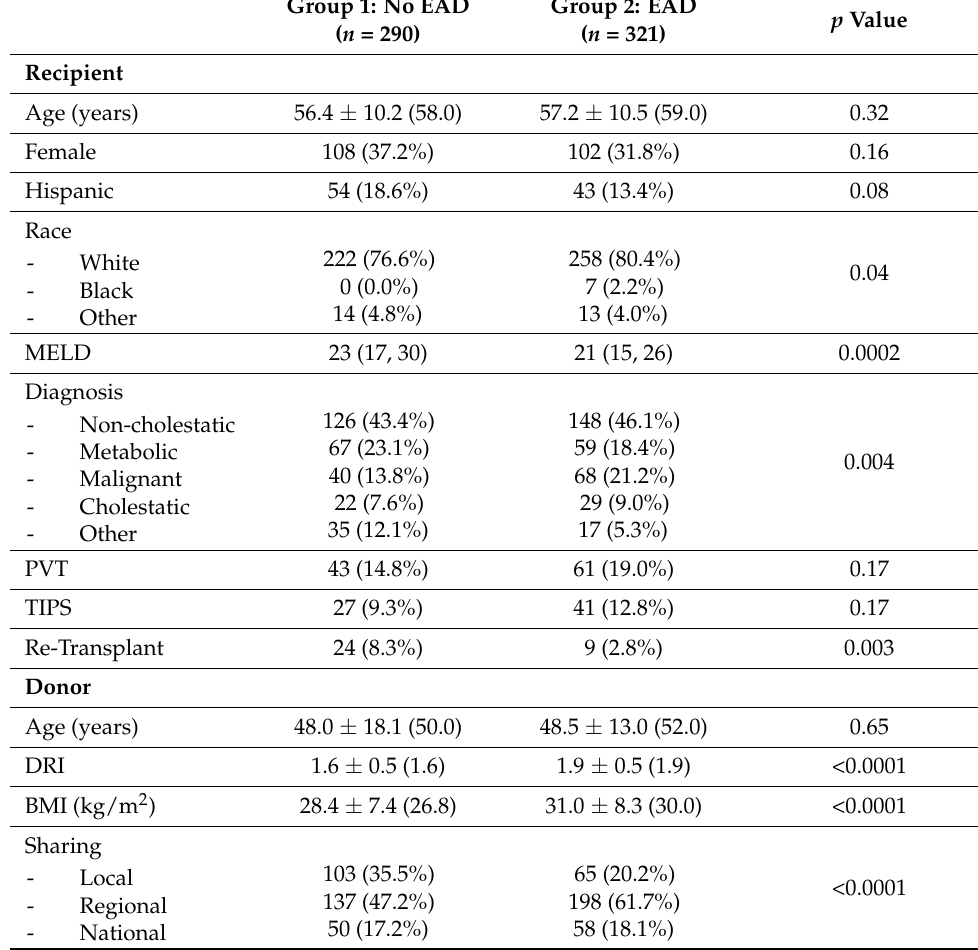
Table 1. Recipient and donor